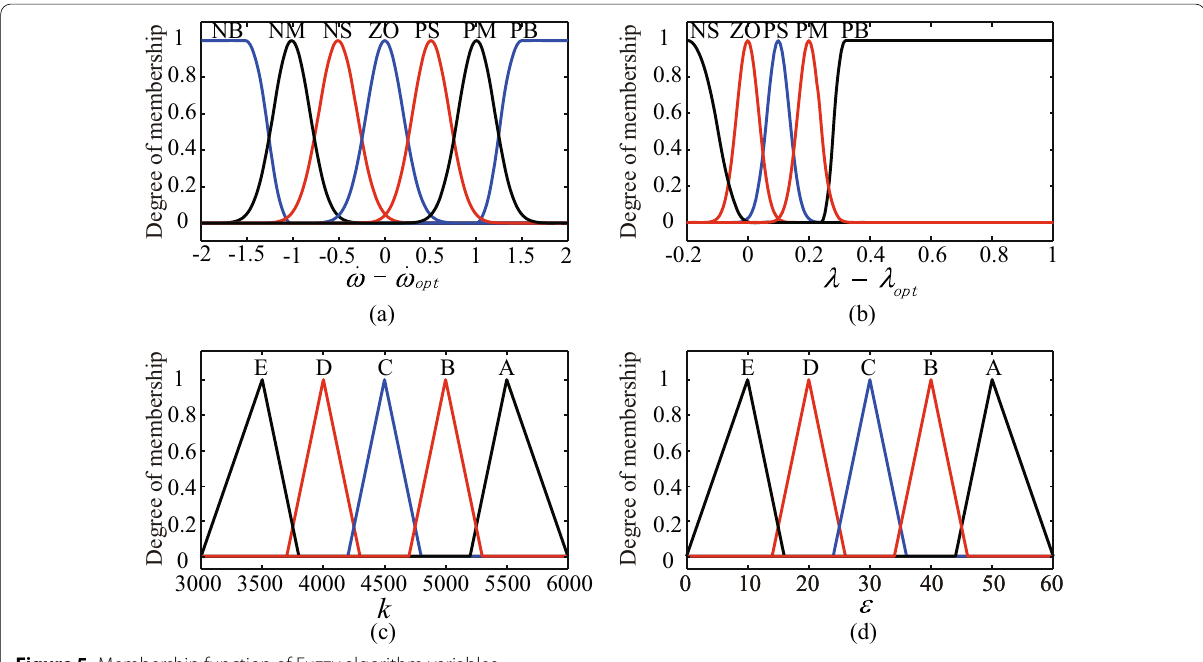
Figure 5 Membership function of Fuzzy algorithm